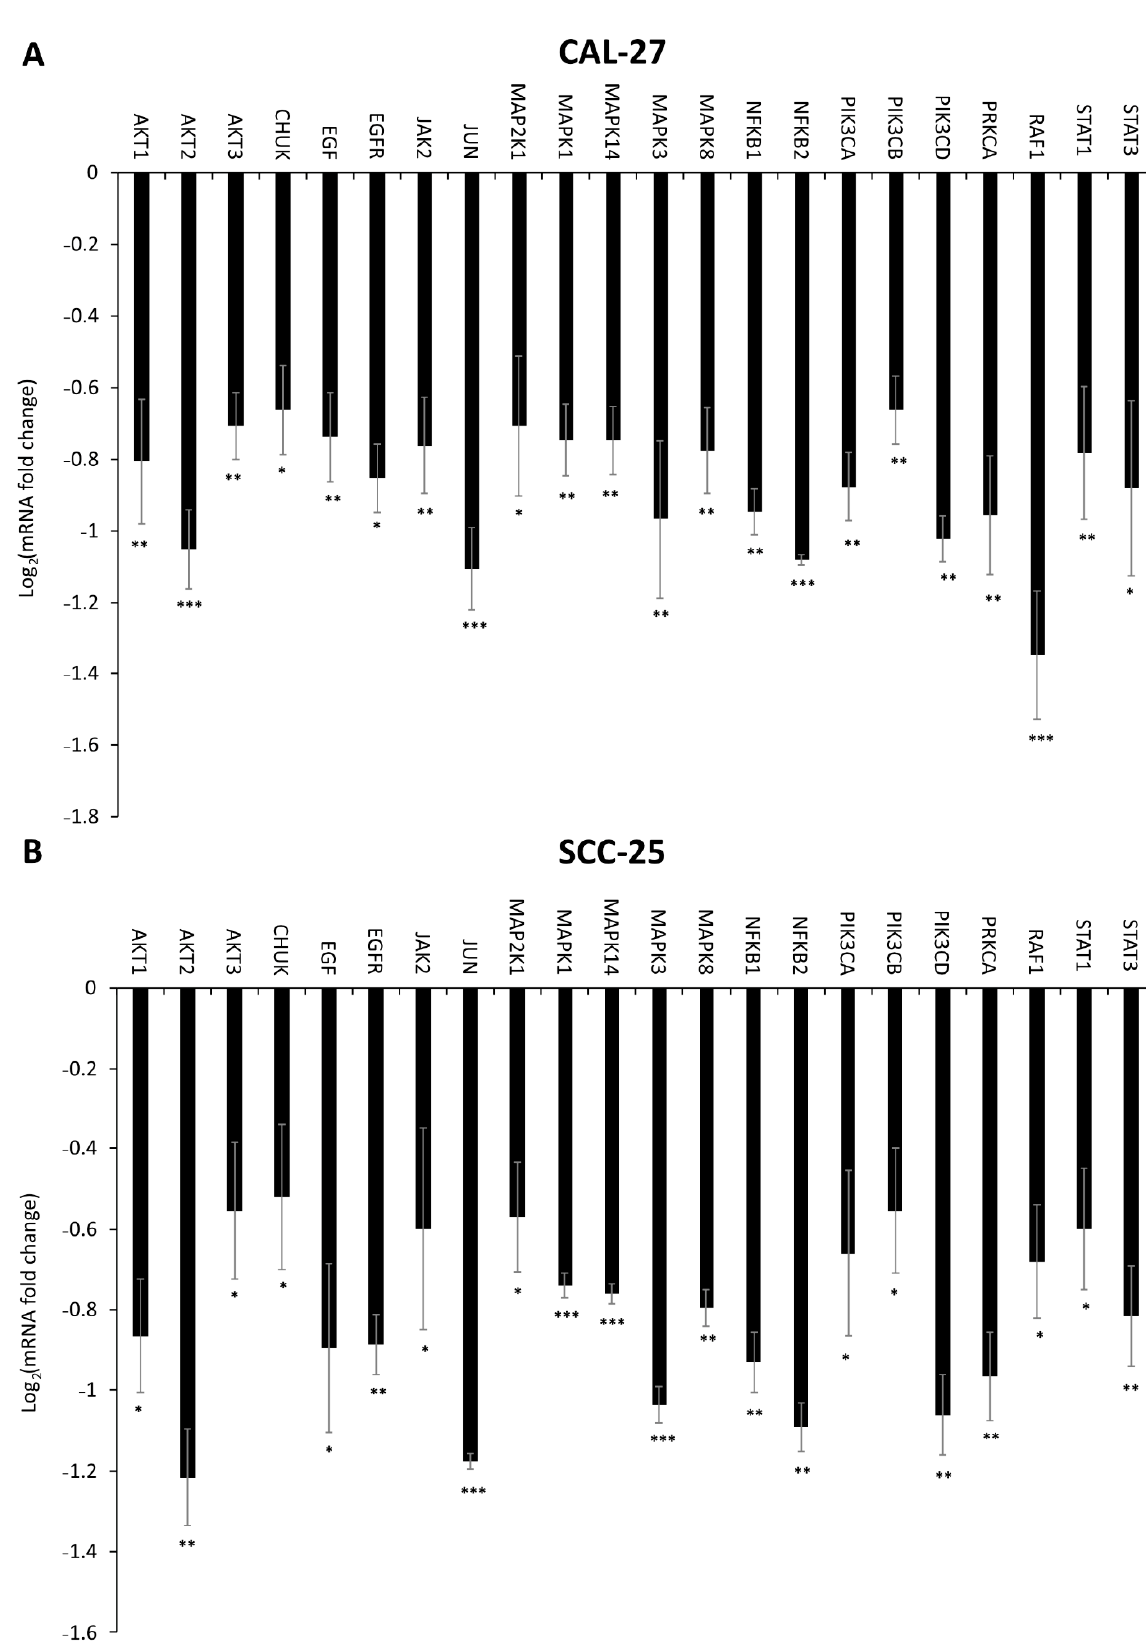
Figure 6. The effect of DMU-214 (5 μ M) on the expression of EGFR signaling pathway-related genes in CAL-27 ( A ) and SCC-25 ( B ) cell lines. Results of three independent replicates are presented as mean ± SD. *** p < 0.001, ** p < 0.01, * p < 0.05 indicate a significant difference from the control.